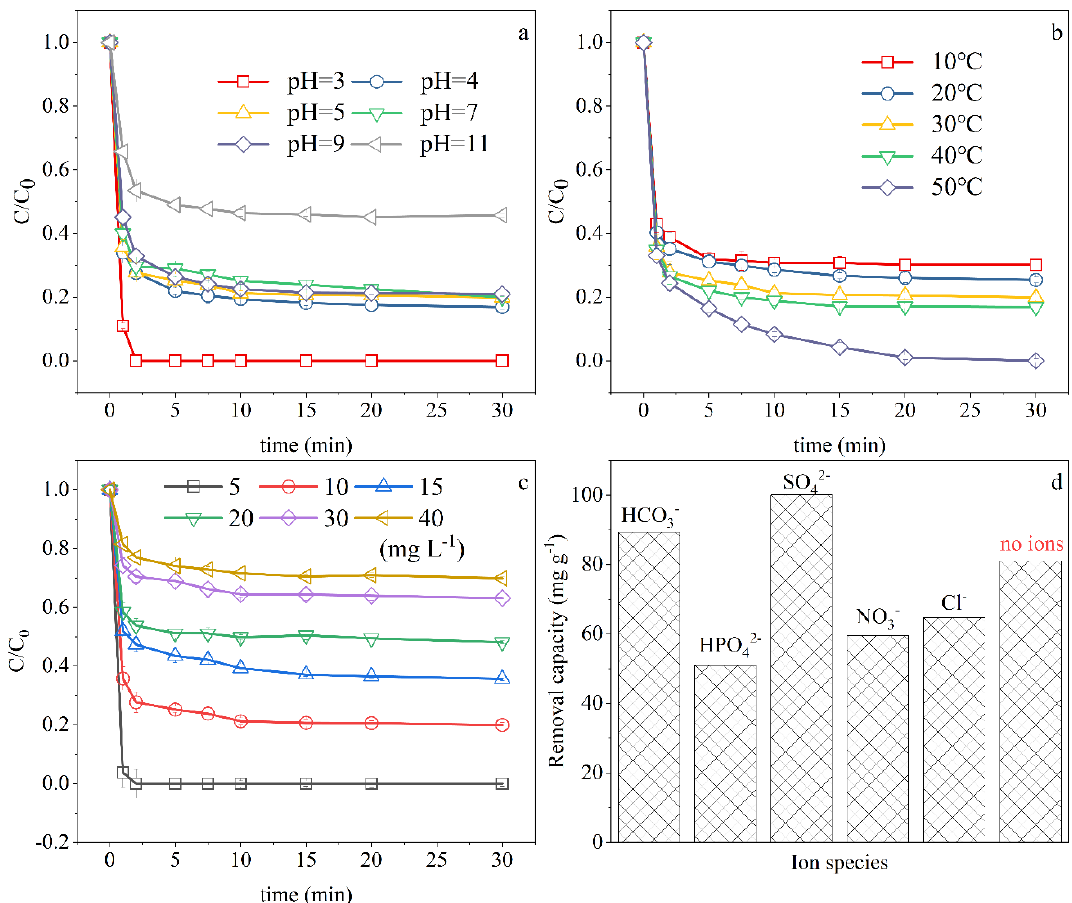
Figure 3. Effects of environmental factors: ( a ) Initial pH, ( b ) temperature, ( c ) initial Cr(VI) concentration, and ( d ) coexisting anions. Fixed experimental conditions: Temperature, 30 °C; pH = 5; initial concentration, 10 mg L − 1 ; dosage of nZVI/rGO, 0.1 g L − 1 ; ultrasonic frequency = 40 kHz.